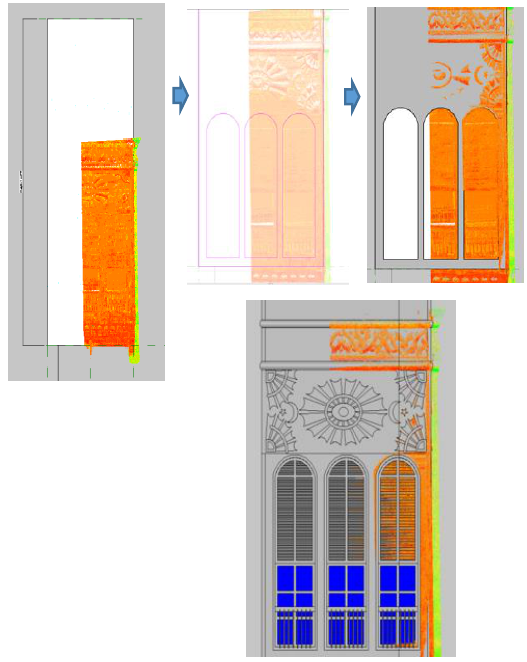
Figure 10. Steps of modelling the main Roshan of Nasif Historical House.